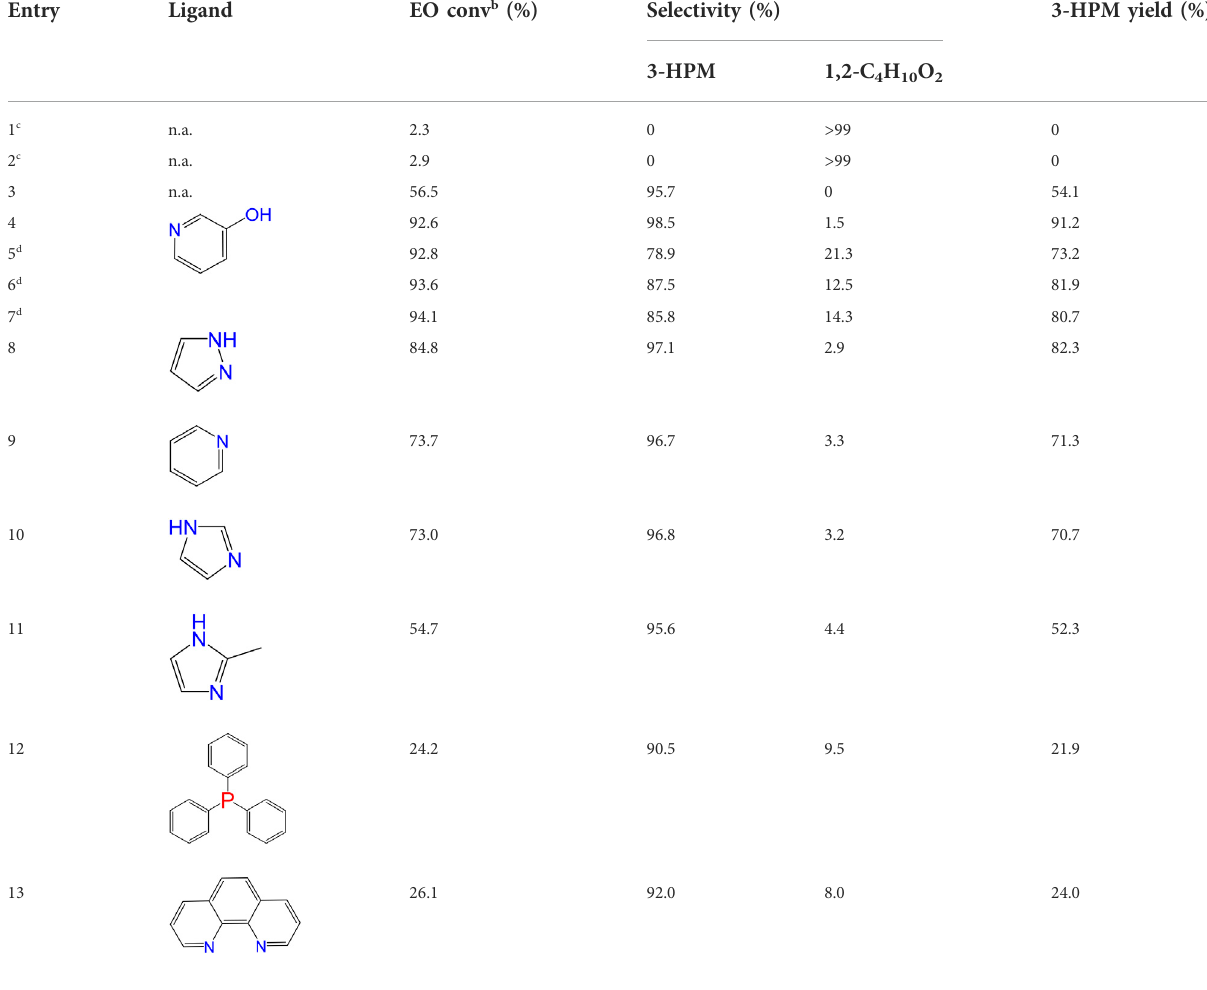
TABLE 1 Catalytic performances of Co 2 (CO) 8 for the carbonylative transformation of EO into 3-HPM at different conditions a